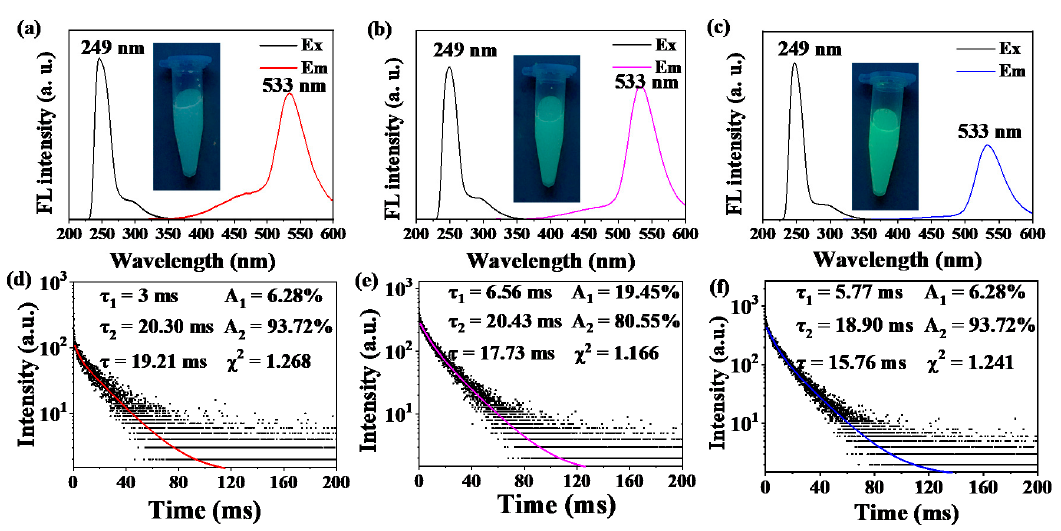
Figure 2. The luminescence spectra and the luminescence lifetime of the ZGO: Mn with different Mn 2+ (0.1% Mn 2+ : a , d ; 0.25% Mn 2+ : b , e ; 0.5% Mn 2+ : c , f ). The illustrations in a , b , c are photos of the PLNPs under 254nm excitation.